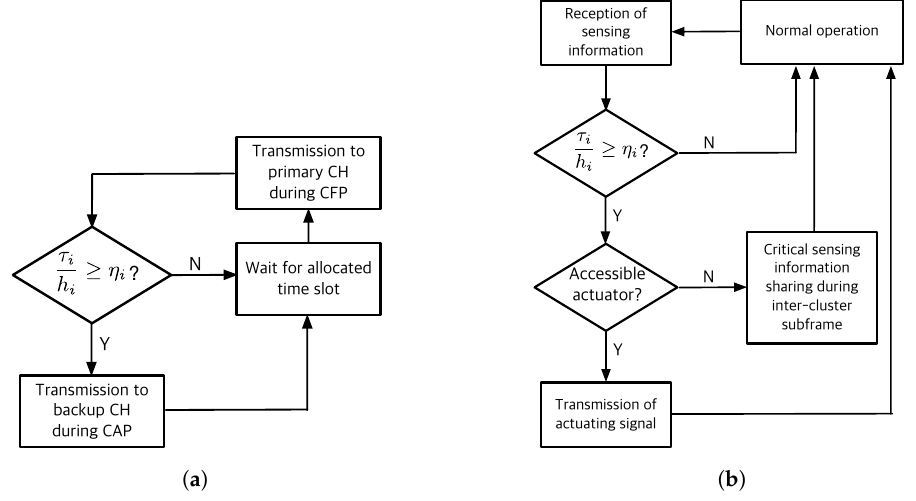
Figure 5. Control task sharing policy of critical loops. ( a ) Access policy to backup cluster head of critical sensor node; ( b ) Backup cluster head operation for control task